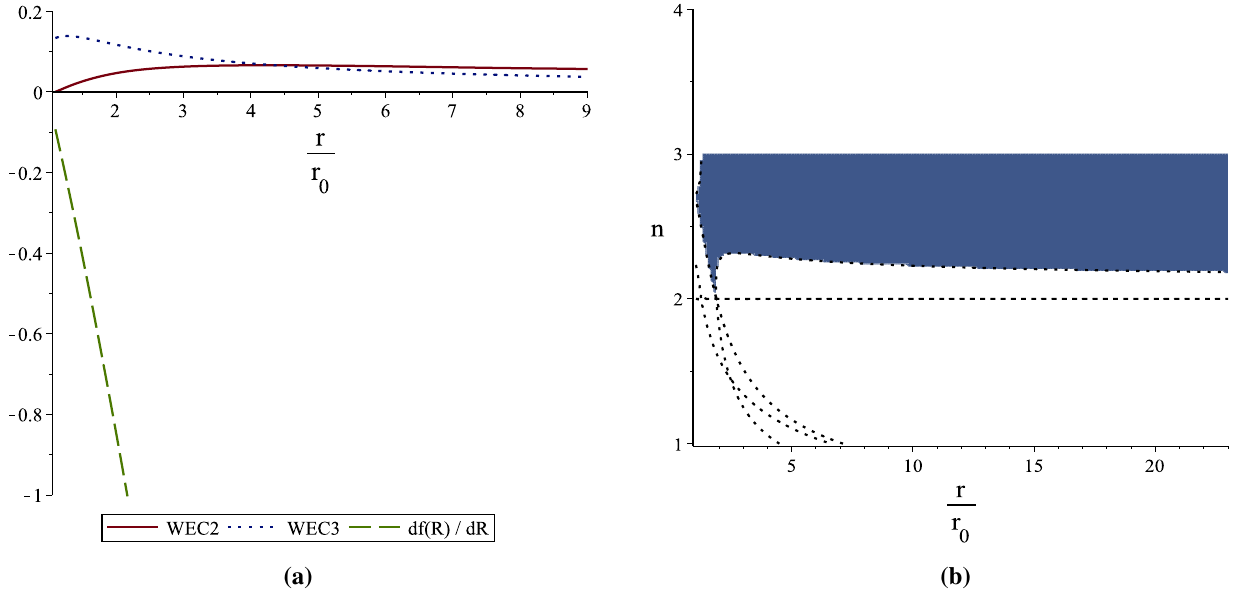
Fig. 6 The NEC for a wormhole solution in the case of Amendola–Gannouji–Polarski–Tsujikawa model is respected ( a ). In the blue part in b , traversable asymptoticly flat wormholes respect the NEC. In these figures we set μ = 5 , R ∗ = 0 . 01 , p = 0 . 5 and r 0 = 3